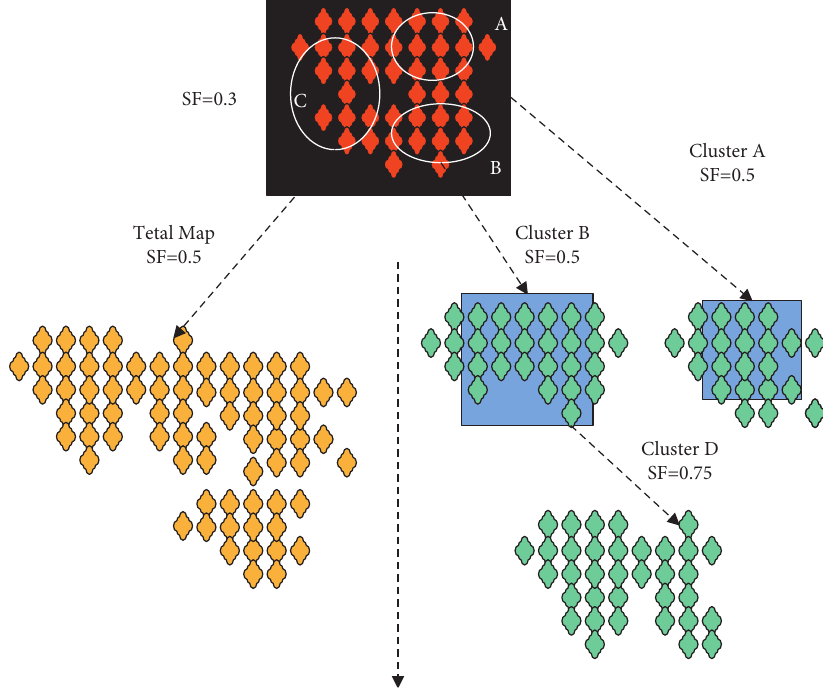
Figure 4: Data analysis based on the value of